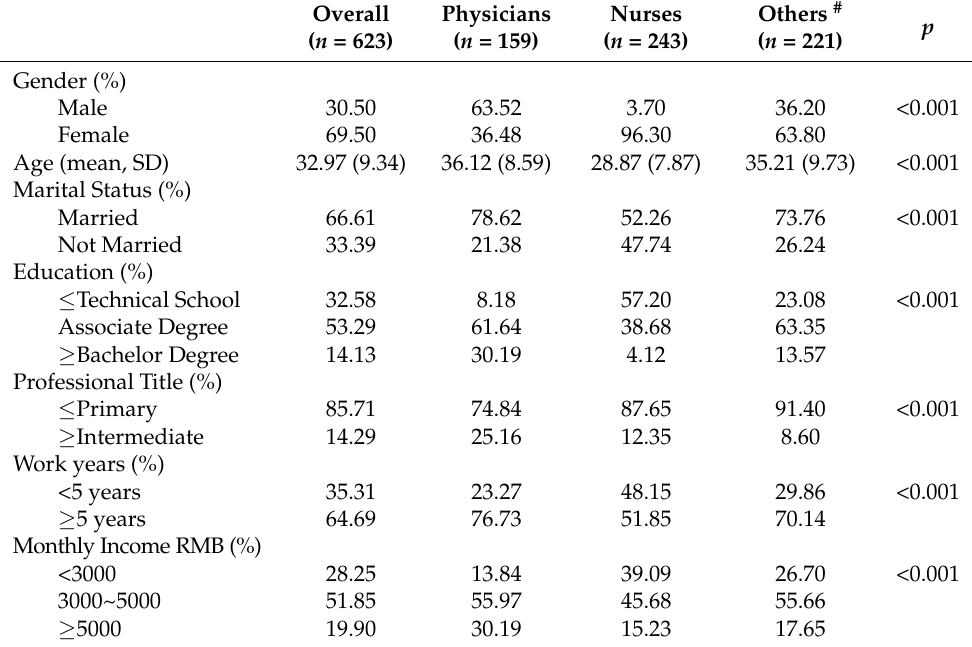
Table 2. Characteristics of the